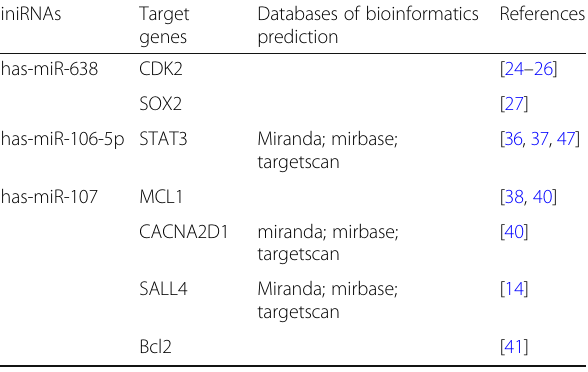
Table 3 Target genes of different miRNAs iniRNAs Target Databases of bioinformatics genes